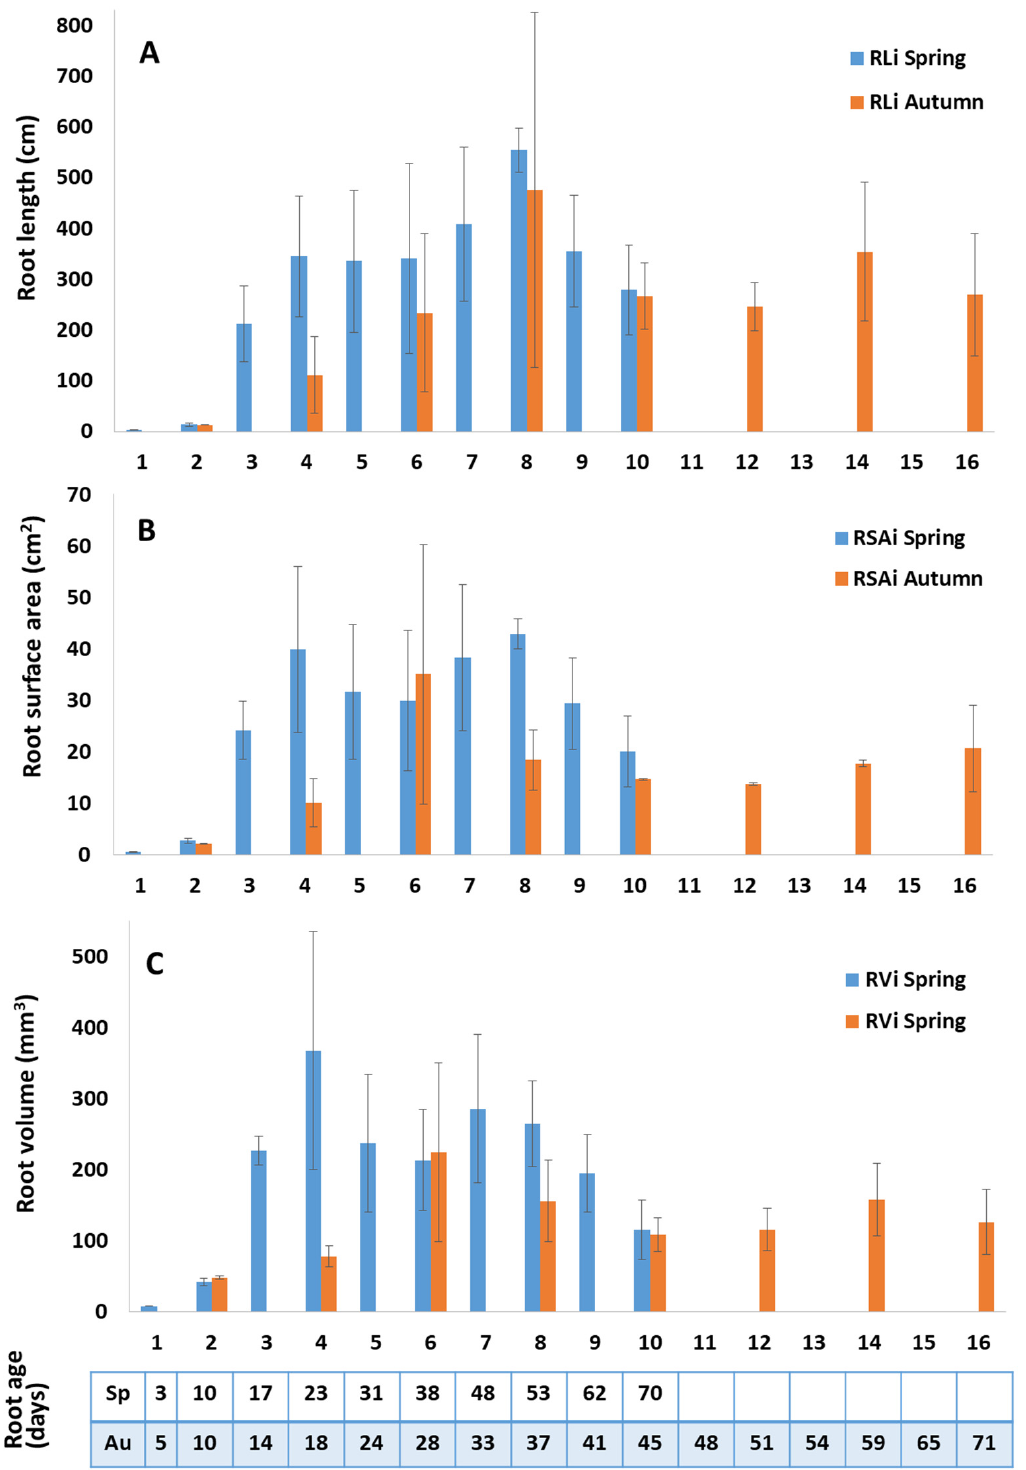
Figure 3. Individual root measures at successive root bearing phytomer positions (Pr) for Aberdart perennial ryegrass in the spring (Sp) and autumn seasons (Au); ( A ) total root length of individual roots (RLi), ( B ) root surface area of individual roots (RSAi) and ( C ) root volume of individual roots (RVi). The panel below shows root age in spring (Sp) and autumn (Au) in days. Data are from two plants in each season whose roots dissected by phytomer position were scanned in WinRhizo ® (Regent Instruments Inc., Quebec, Canada). Vertical bars indicate the standard error of the mean value.